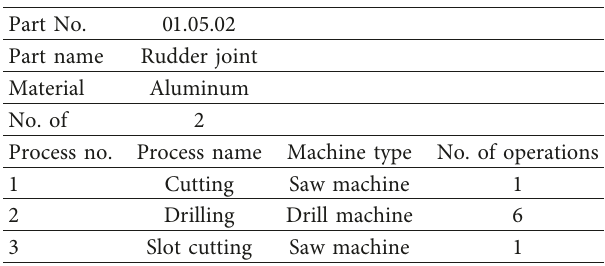
Table 5: Net of the boat.